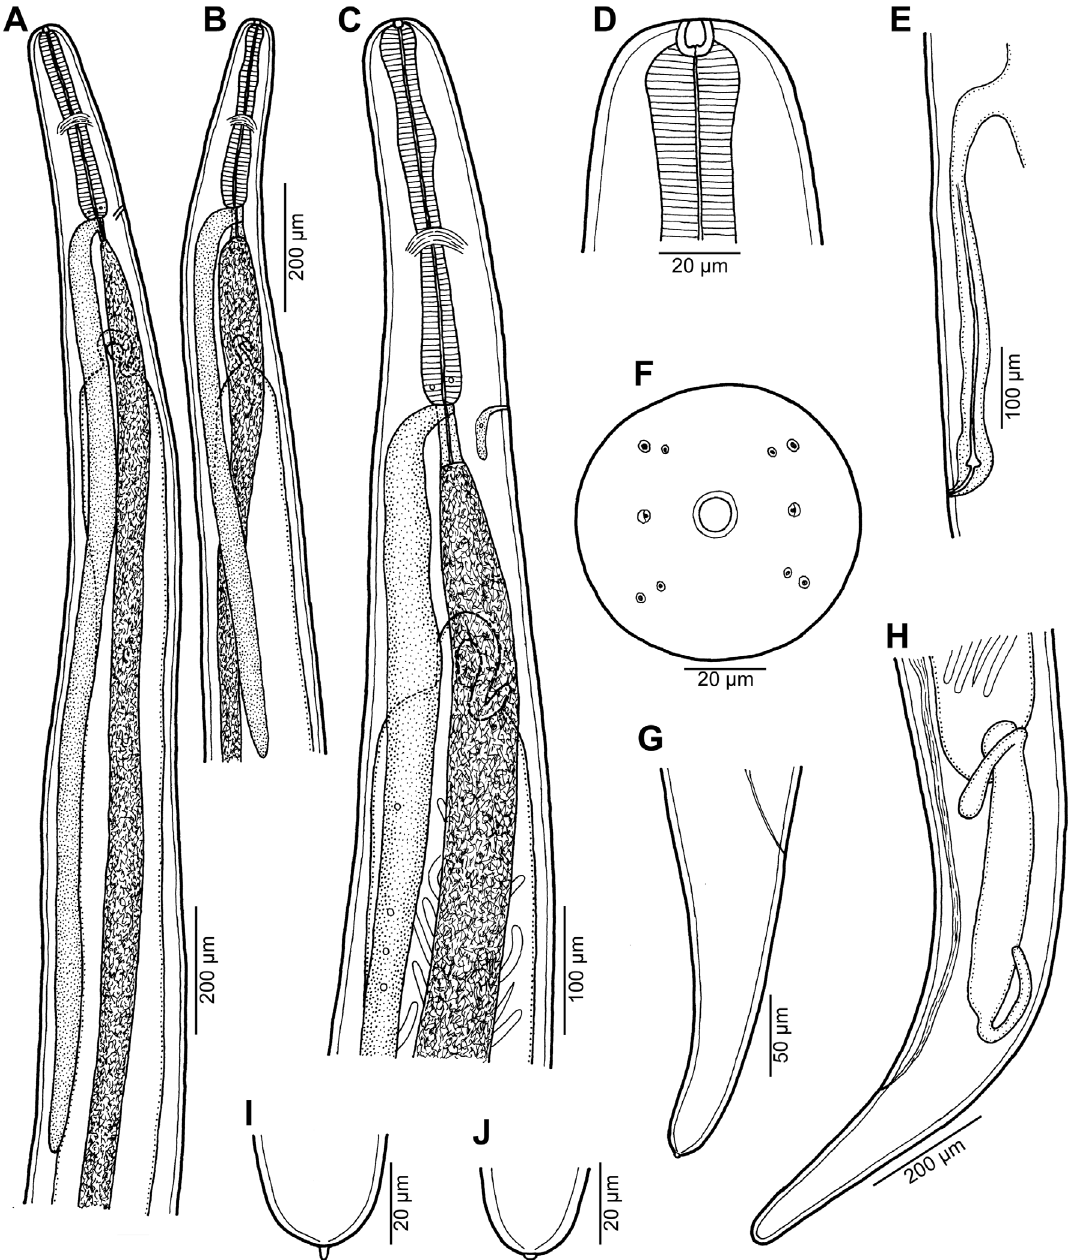
Figure 1. Ichthyo fi laroides novaecaledoniensis (Moravec et Justine, 2009) n. comb., gravid female from Hoplichthys citrinus . (A, B) Anterior ends of two different specimens, lateral views; (C) anterior end, lateral view (enlarged); (D) cephalic end, lateral view; (E) vulva and vagina, lateral view; (F) cephalic end, apical view; (G) tail, lateral view; (H) posterior end, lateral view; (I, J) tail tips of two different